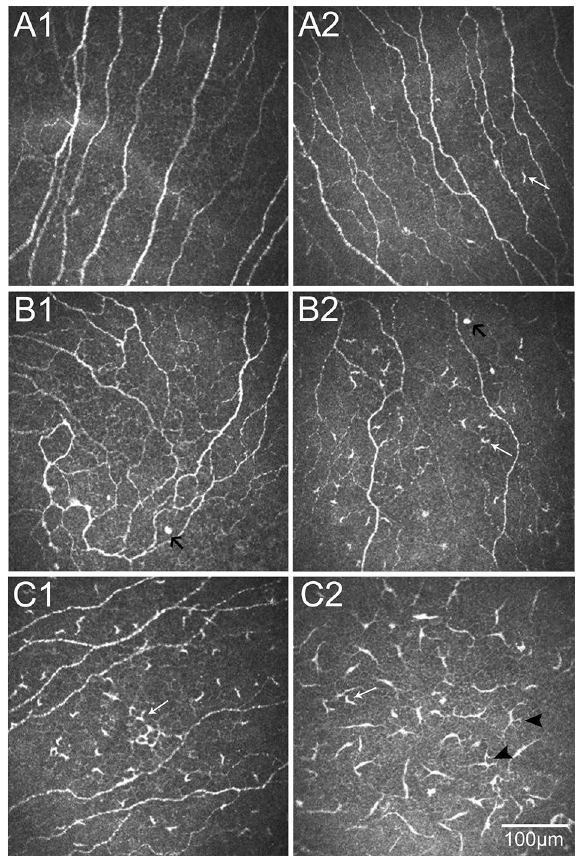
Figure 2. Representative in vivo confocal microscopic images of corneal epithelial dendritic cell (DC) in three groups. ( A ) Central cornea of a healthy volunteer, showing without DC ( A1 ) and small DCs with two processes (white arrow) ( A2 ). ( B ) Central cornea of a 39-year-old female patient with non-Sjogren’s syndrome dry eye (NSSDE), showing hyperreflective DCs without dendritic process (black arrow in B1 and B2 ) and a higher density of DCs ( B2 ) with two processes (white arrow). ( C1 and C2 ) Central cornea of a 43-year-old female patient with Sjogren’s syndrome dry eye (SSDE), showing a great number of DCs with two (white arrow) and longer processes